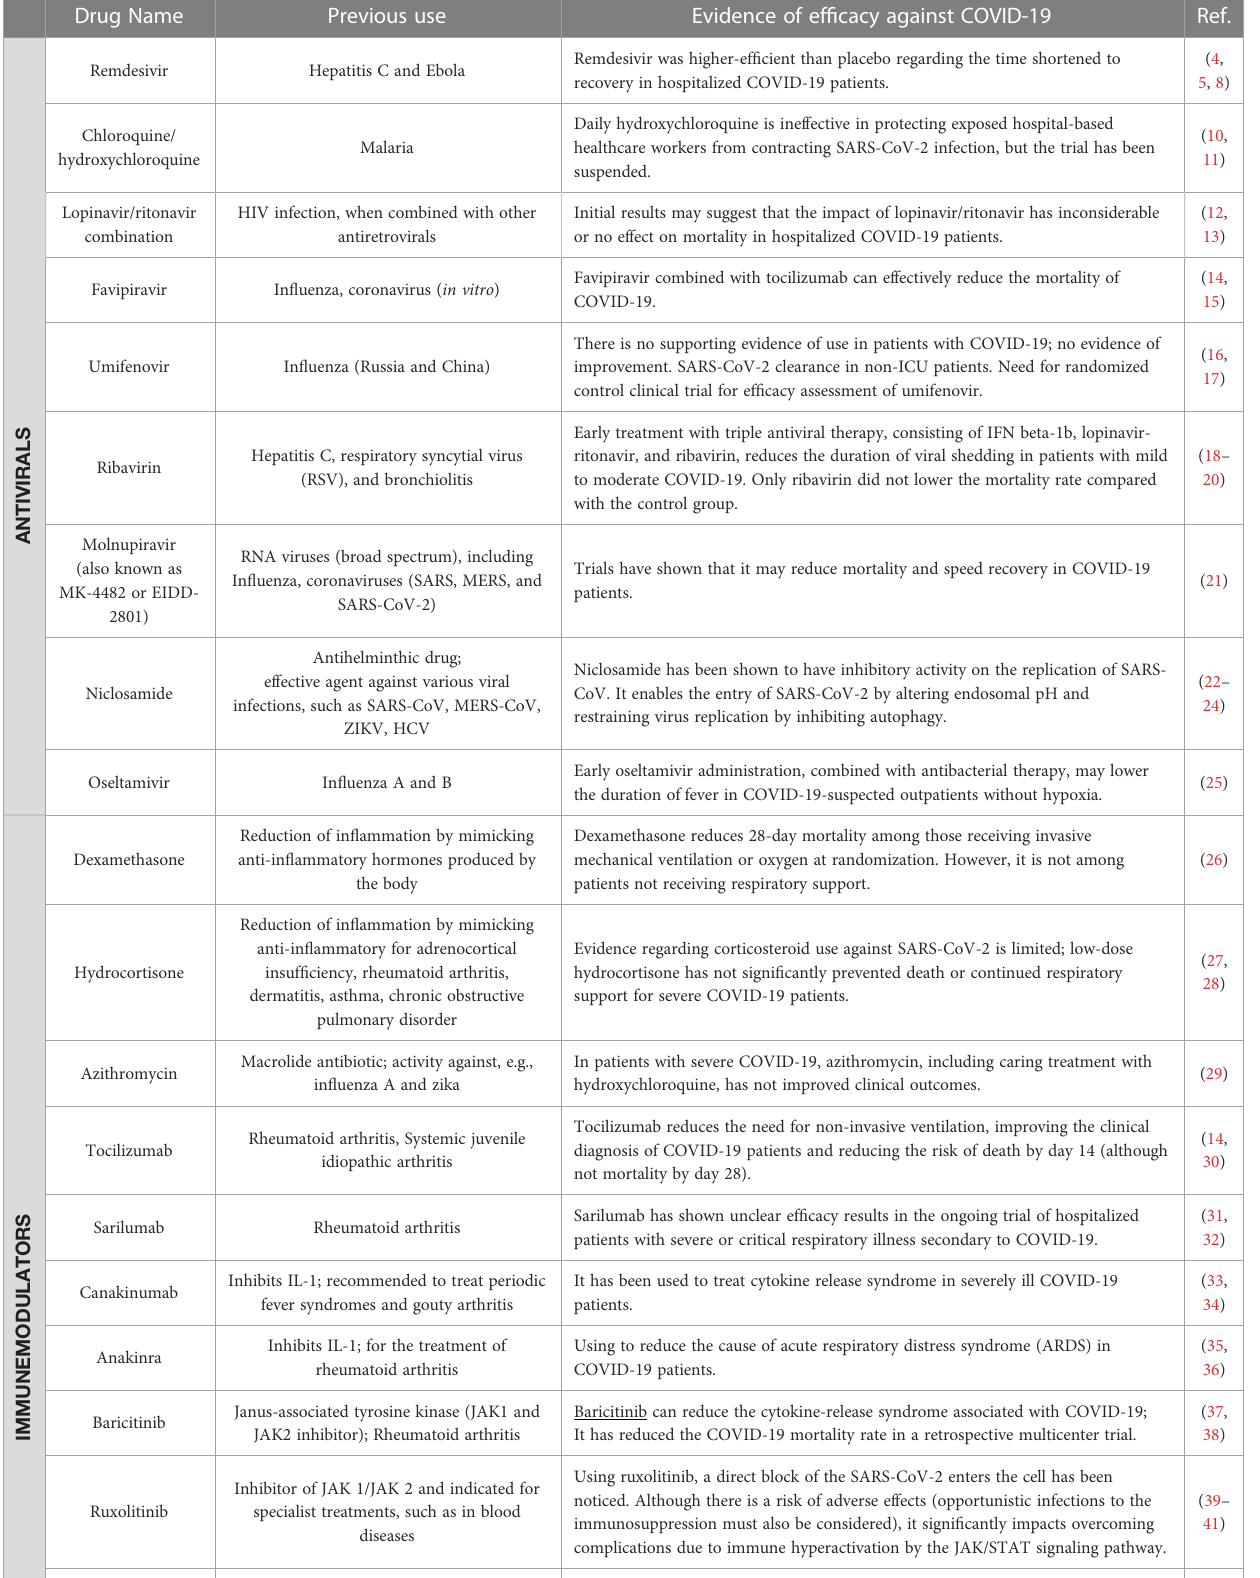
TABLE 1 Identi fi cation of the potential drugs for treating COVID-19. Drug